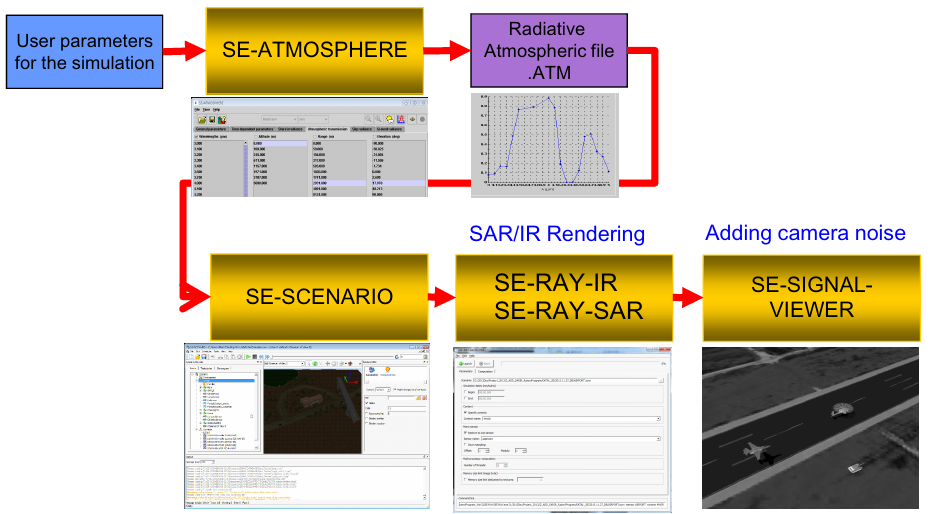
Figure 18. OKTAL-SE-based SAR and IR image generation flow.